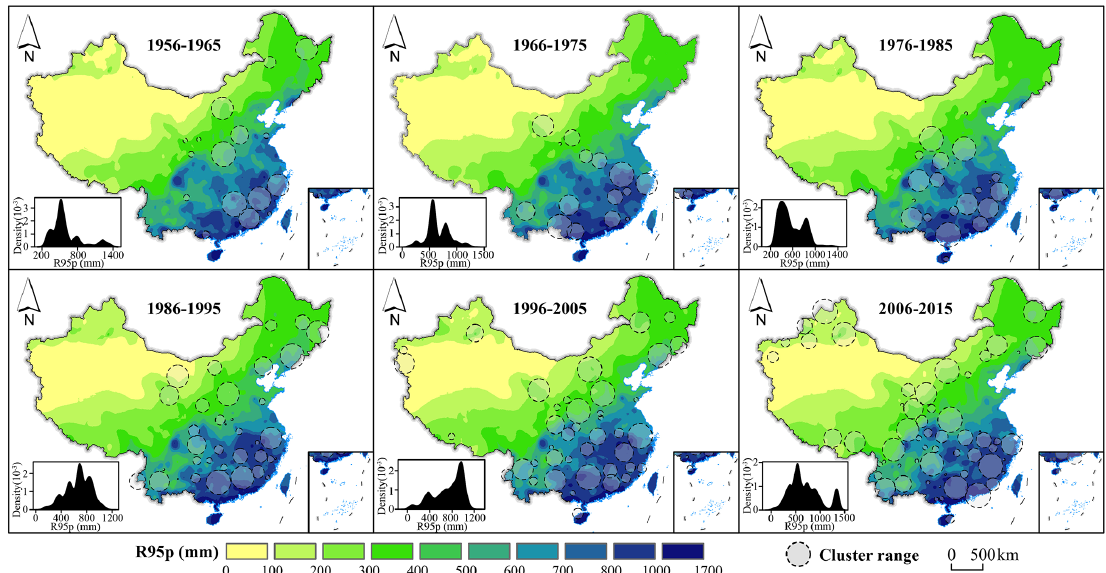
Figure 8. Significant ( p < 0 . 005) spatiotemporal clusters of flash flood disasters in China every 10 years. The size of the circles indicates the spatial coverage of the flash flood clusters we detected.